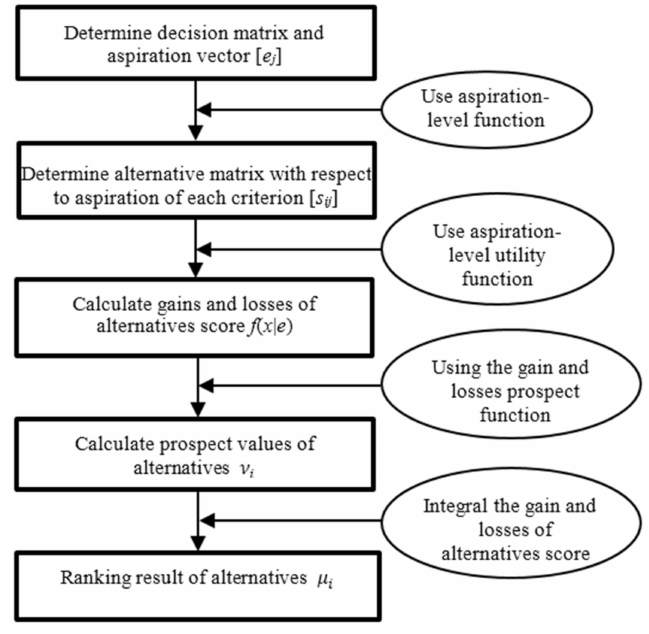
Figure 2. Proposed